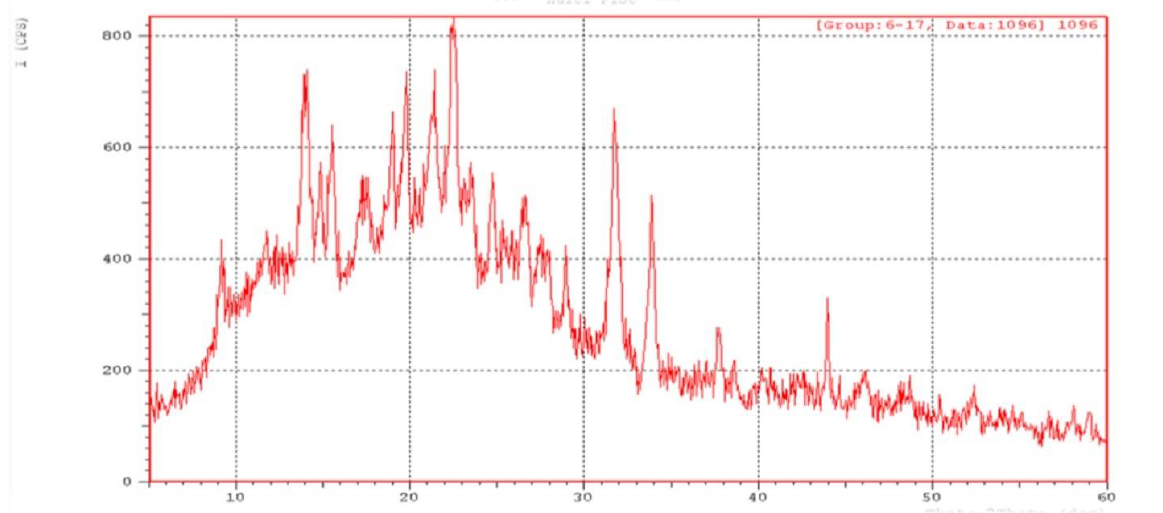
Figure 11. XRPD spectrum of F8 Fourier Transform Infrared Spectroscopy (FTIR) FTIR was carried out for domperidone and nanoparticles of F8. Domperidone exhibited a strong characteristic absorbance band at 1714 cm - 1 due to C = O stretching vibrations of amide functional group CONHR, and N ̶ H bending characteristic band at 1693 cm -1 , N ̶ H stretching band of secondary amine appeared at 3126 cm -1 as a single band, symmetric and asymmetric C ̶ H stretching bands appeared at 2810 and 2941 cm -1